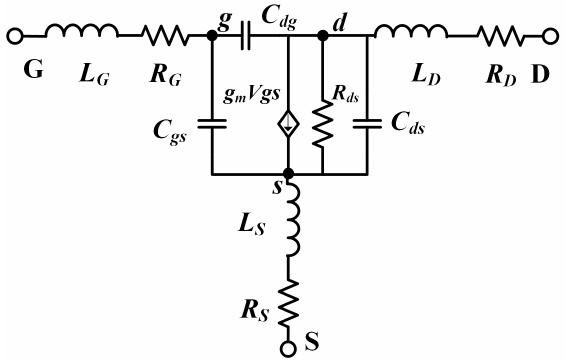
Figure 3. Conventional small-signal model of power MOSFETs.